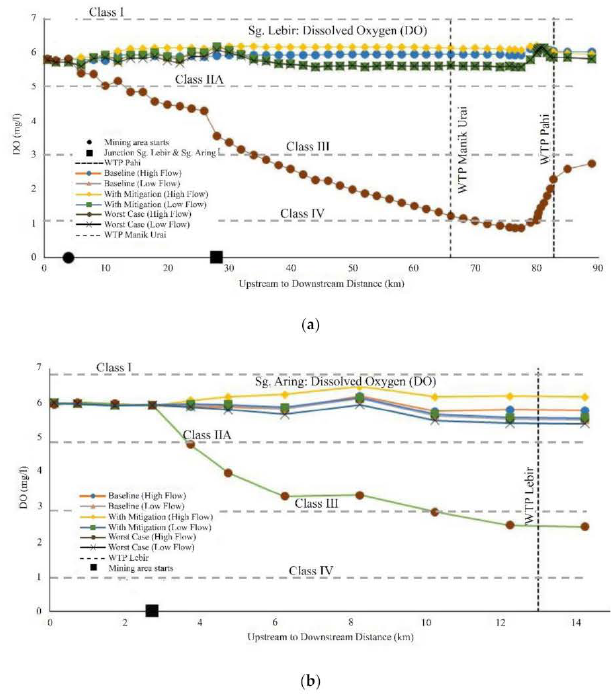
Figure 4. ( a , b ) showing DO concentration in different scenarios for Sungai Lebir and Sungai Aring,